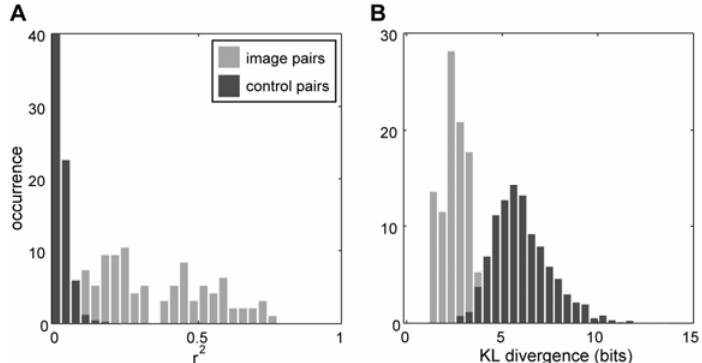
Figure 7. Fixation behaviour is similar in V and AV conditions. A: The distribution of r2 values calculated for image-paired V and AV saliency maps (light grey) and control pairings of V and AV image pdfs (dark grey). B: The distributions of Kullback-Leibler divergences of AV from V image pdfs, again with actual image pairings shown in light grey, and control pairings in dark grey. Actual and control distributions are significantly different in both cases.